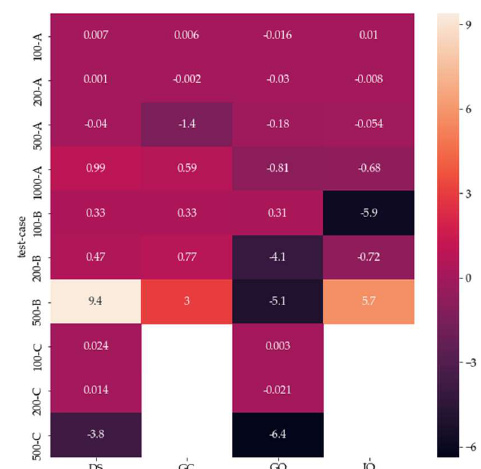
Figure 10. Average response time difference (in seconds) between gevent and mod_wsgi WSGI servers registered during the load testing in case A, B and C with 100, 200, 500 and 1000 users. Positive values indicate that mod_wsgi was slower; on the contrary, negative values indicate that gevent was faster.